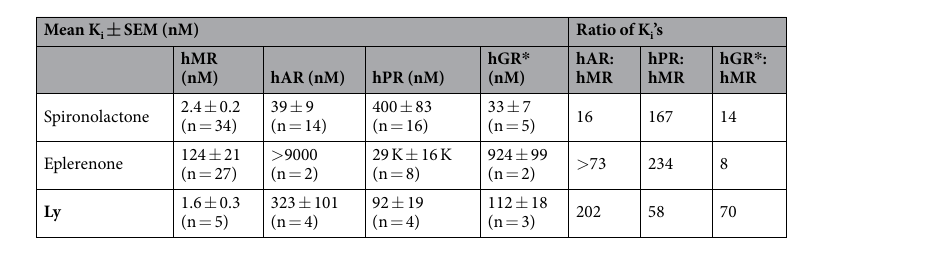
Table 1. Binding K i for Nuclear Receptors expressed in Sf9 and HEK293 Cells. Mean ± 1 SE; hMR human mineralocorticoid receptor; hAR human androgen receptor; hPR human progesterone receptor; hGR * human glucocorticoid